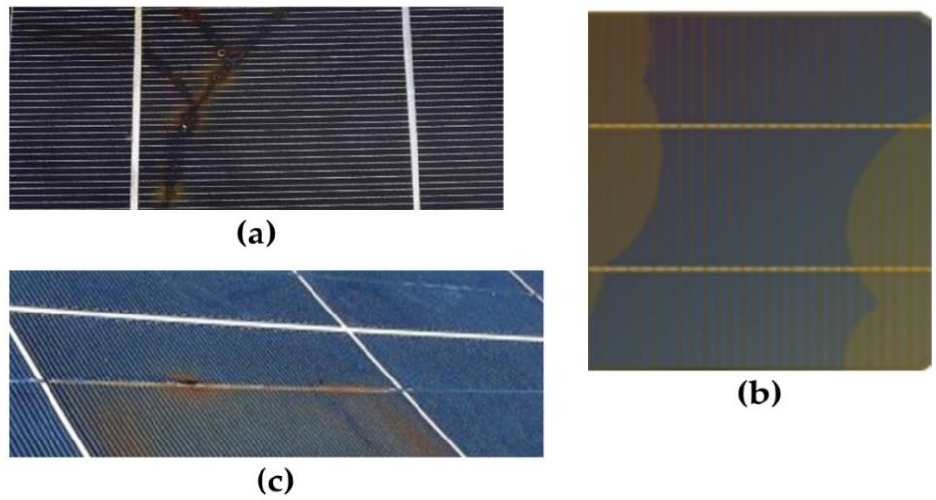
Figure 4. Typical PV module degradation signatures ( a ) cracked cell sample, ( b ) discolored encapsulant sample, ( c ) corroded sample.